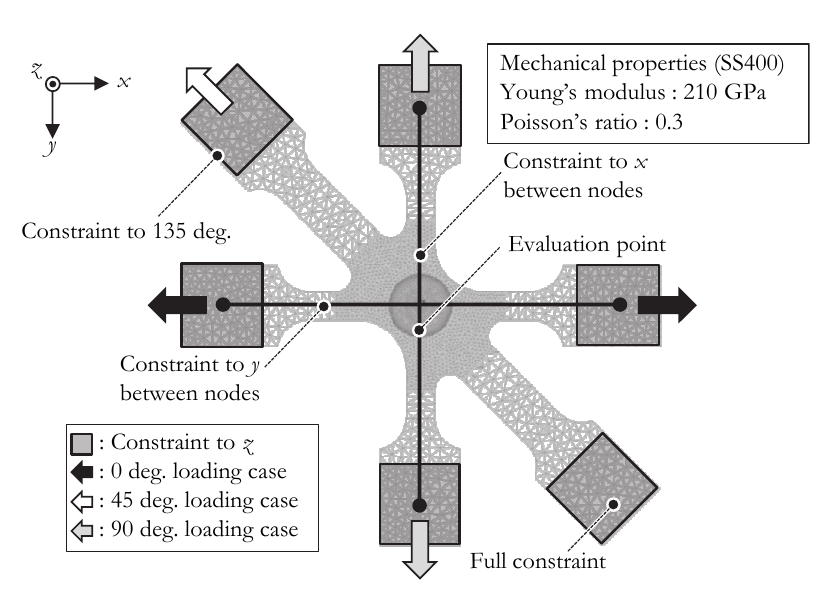
Figure 4: FE model with constraint conditions of testing